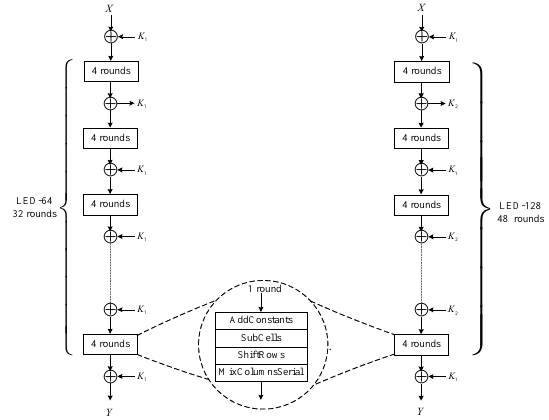
Fig. 1. The structure of LED-64 and LED-128